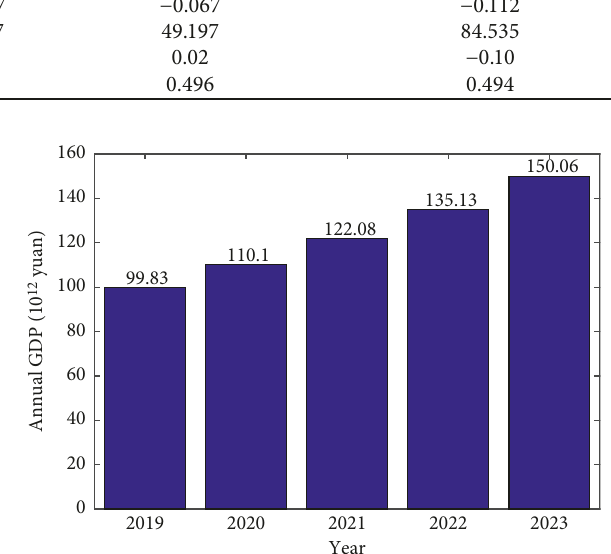
Figure 3: The predicted values of China’s GDP from 2019 to 2023 by the optimized NGBM(1,1) model.